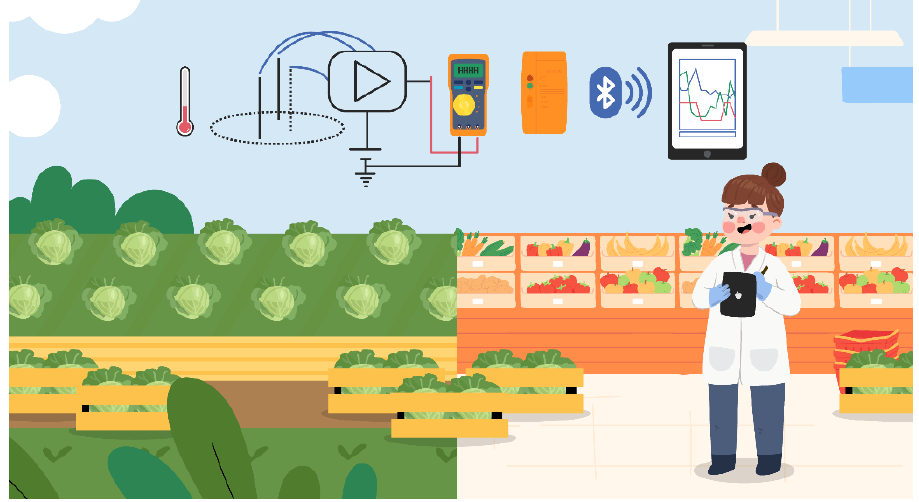
Figure 7. The experimental setup and onsite application of the multiple-input deep learning model.